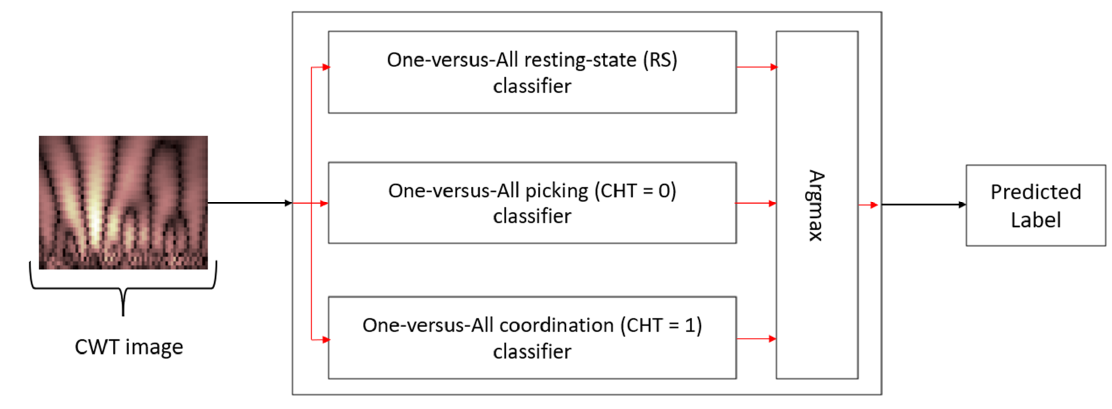
Figure 6. One-versus-all classifier architecture.